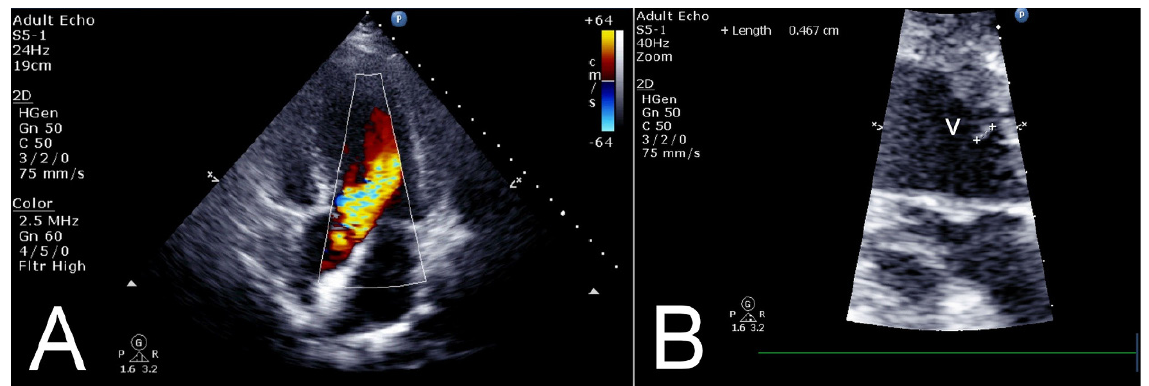
Figure 1. A.Transthoracic echocardiography: an apical five-chamber view with color Doppler showing regurgitation through the aortic valve. B. Transthoracic echocardiography: parasternal long-axis view showing the aortic valve with a floating vegetation (V) (4.7 x 2.0 mm) on the right coronary